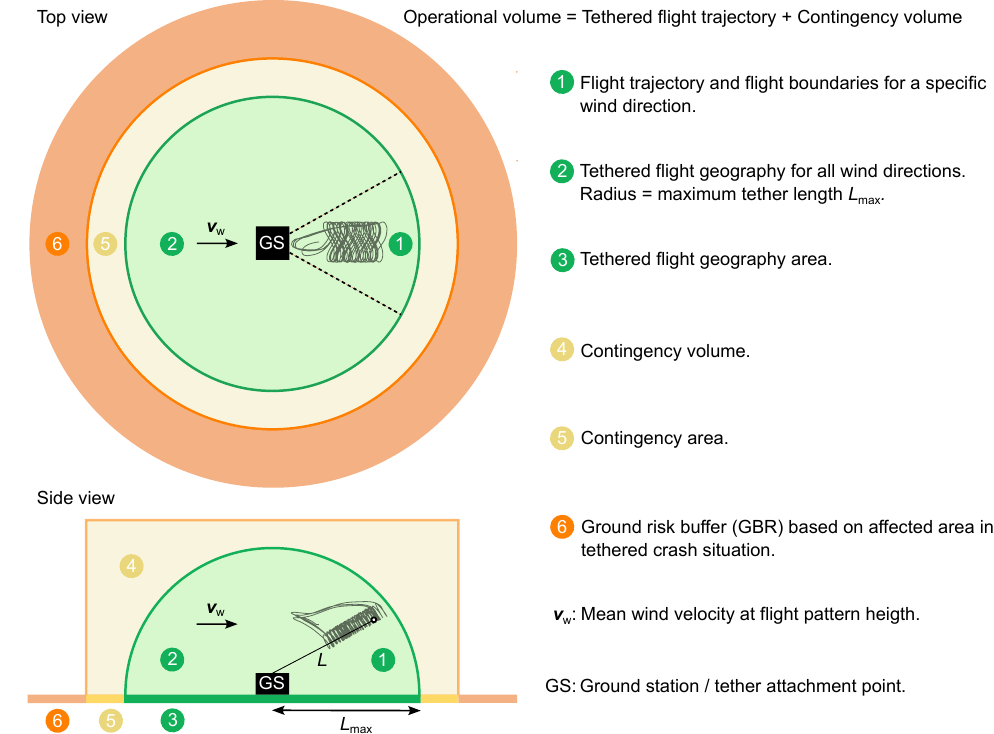
Figure 3. Definition of the operational volume for AWES and related terminology. The ground risk buffer is calculated according to JARUS’ ground risk model with a significant safety